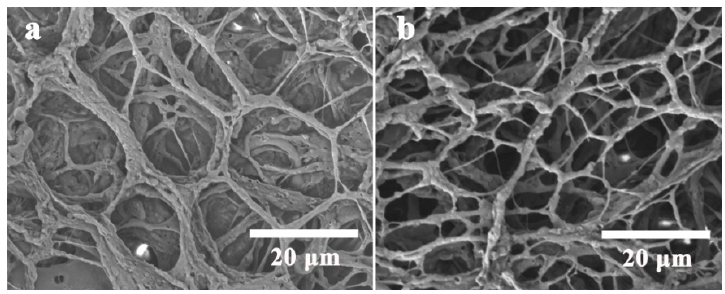
Figure 3. SEM of ( a ) h-PAMAM and ( b ) GS-h-PAMAM.